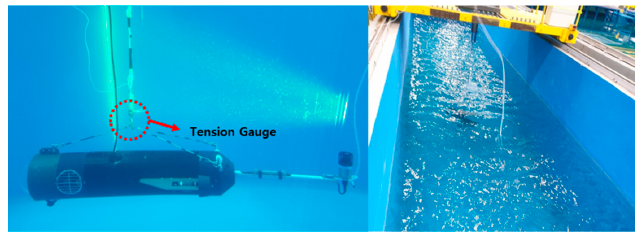
Figure 9. Simulation result of cable motion with current: ( a ) Cable lay-back angle change according to current (0 m/s to 1 m/s); ( b ) Force acting on the last node of the cable.